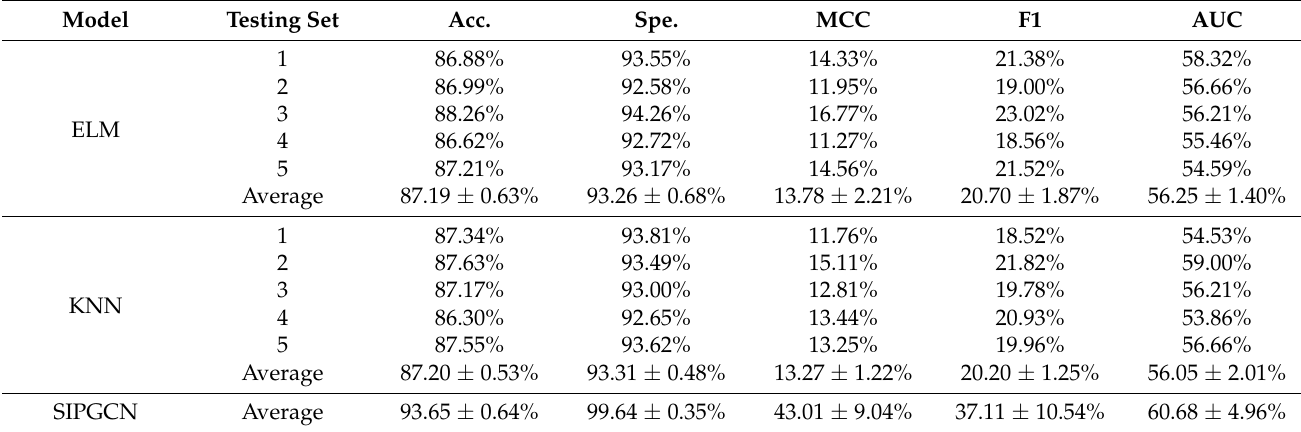
Table 3. The outcomes of different classifier models in the human data set.